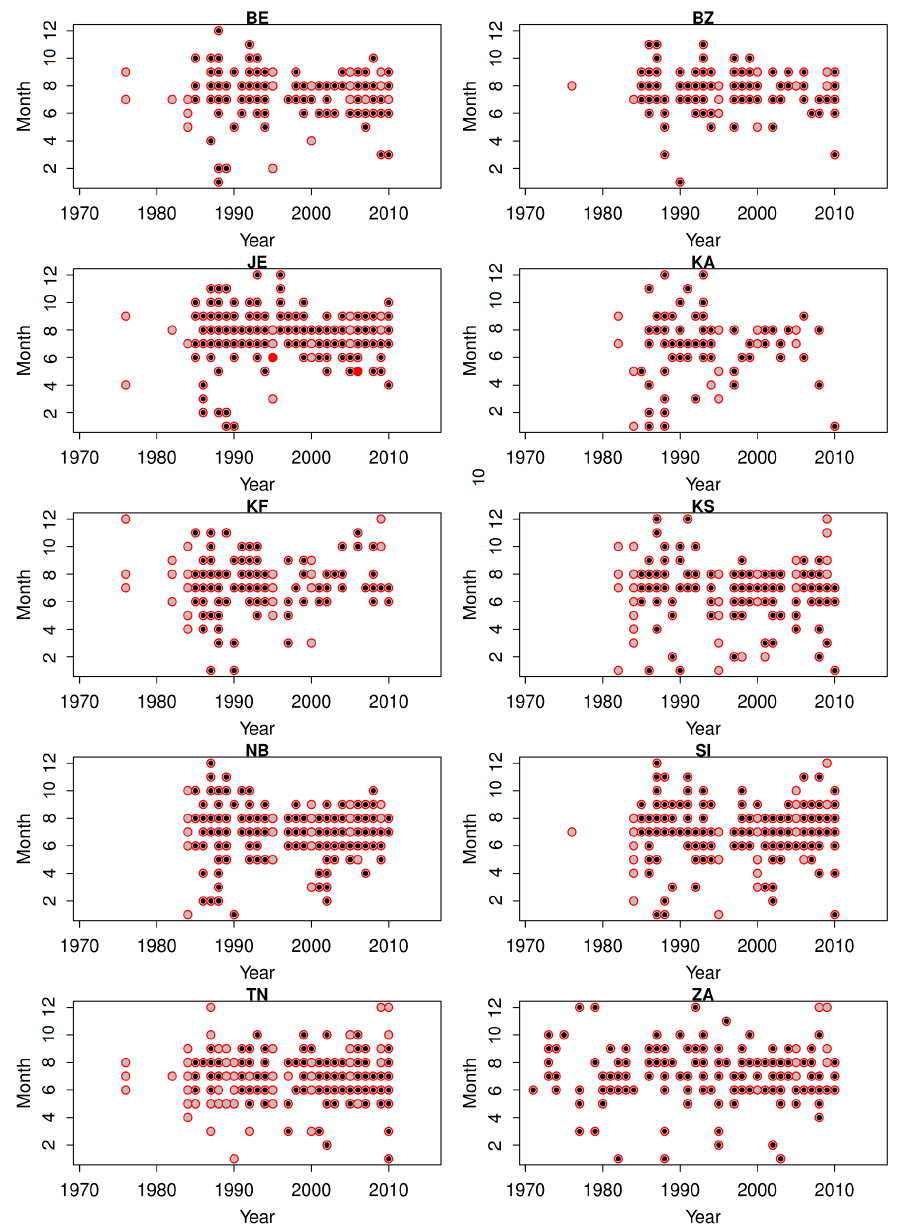
Figure 5. Yearly ( X -axis) and monthly ( Y -axis) distribution of fire records in the DGF database (black dots), RADES (grey dots) and CRDA (red dots) for each ‘ gouvernorat ’. Each dot represents a month where at least one fire has been registered in a given database.